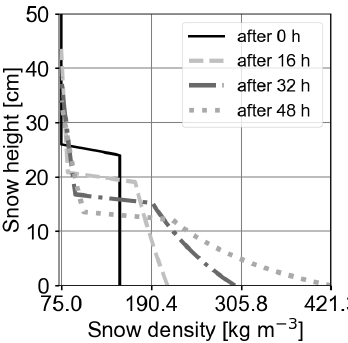
Figure 5. Snow density profiles ( x axis) over snow height ( y axis) at initiation and after 16, 32 and 48h. Snowpack height decreases and snow density increases with time at all locations, but they do so the most in the lower part of the